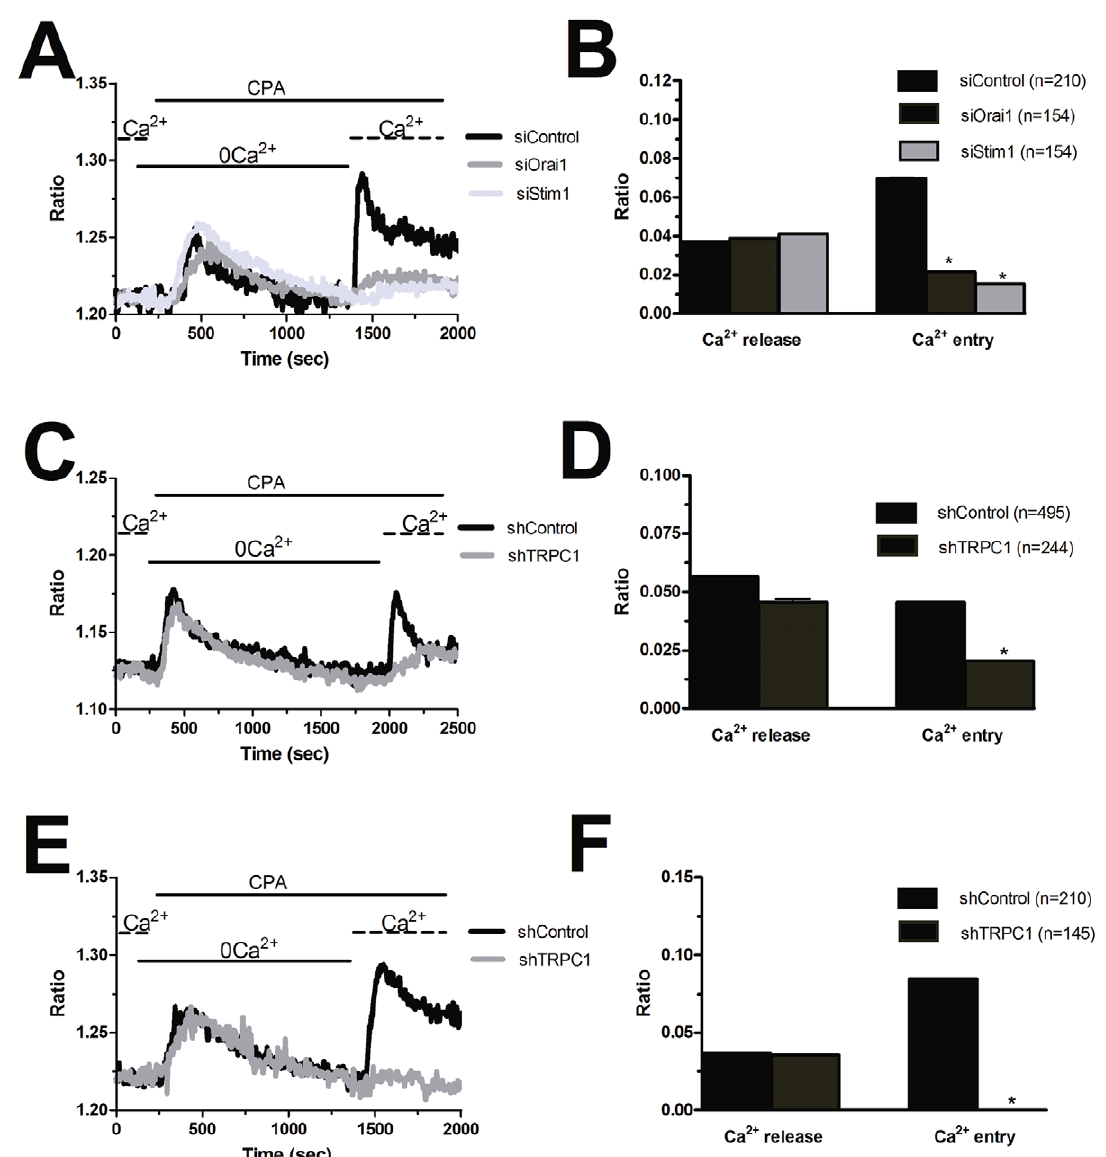
Figure 13. Silencing of Orai1, Stim1, and TRPC1 reduces store-operated Ca 2 + entry in endothelial progenitor cells. A, SOCE evoked by CPA (10 m M) in RCC-EPCs transfected with a control siRNA (black tracing) or with a specific siRNA sequence devised to knock down either Orai1 (grey tracing) or Stim1 (light gray tracing). B, mean 6 SE of the amplitude of CPA-induced Ca 2 + release and CPA-induced SOCE under each condition described in A. The asterisk indicates p , 0.05. C, SOCE triggered by CPA (10 m M) in N-EPCs transfected with a scrambled shRNA (black tracing) and with a shRNA selectively targeting TRPC1 (grey tracing). D, mean 6 SE of the amplitude of CPA-induced Ca 2 + release and CPA-induced SOCE under each condition described in C. E, SOCE triggered by CPA (10 m M) in RCC-EPCs transfected with a scrambled shRNA (black tracing) and with a shRNA selectively targeting TRPC1 (grey tracing). F, mean 6 SE of the amplitude of CPA-induced Ca 2 + release and CPA-induced SOCE under each condition described in